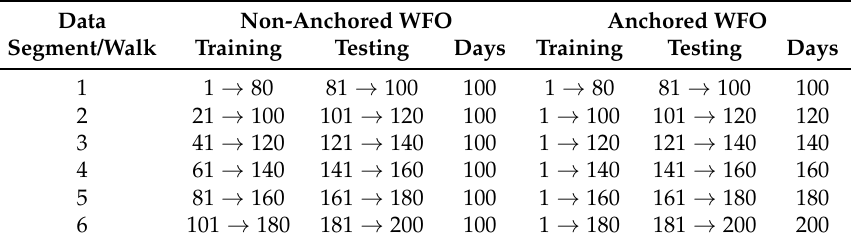
Table 1. Non-anchored and Anchored Walk Forward Optimization.